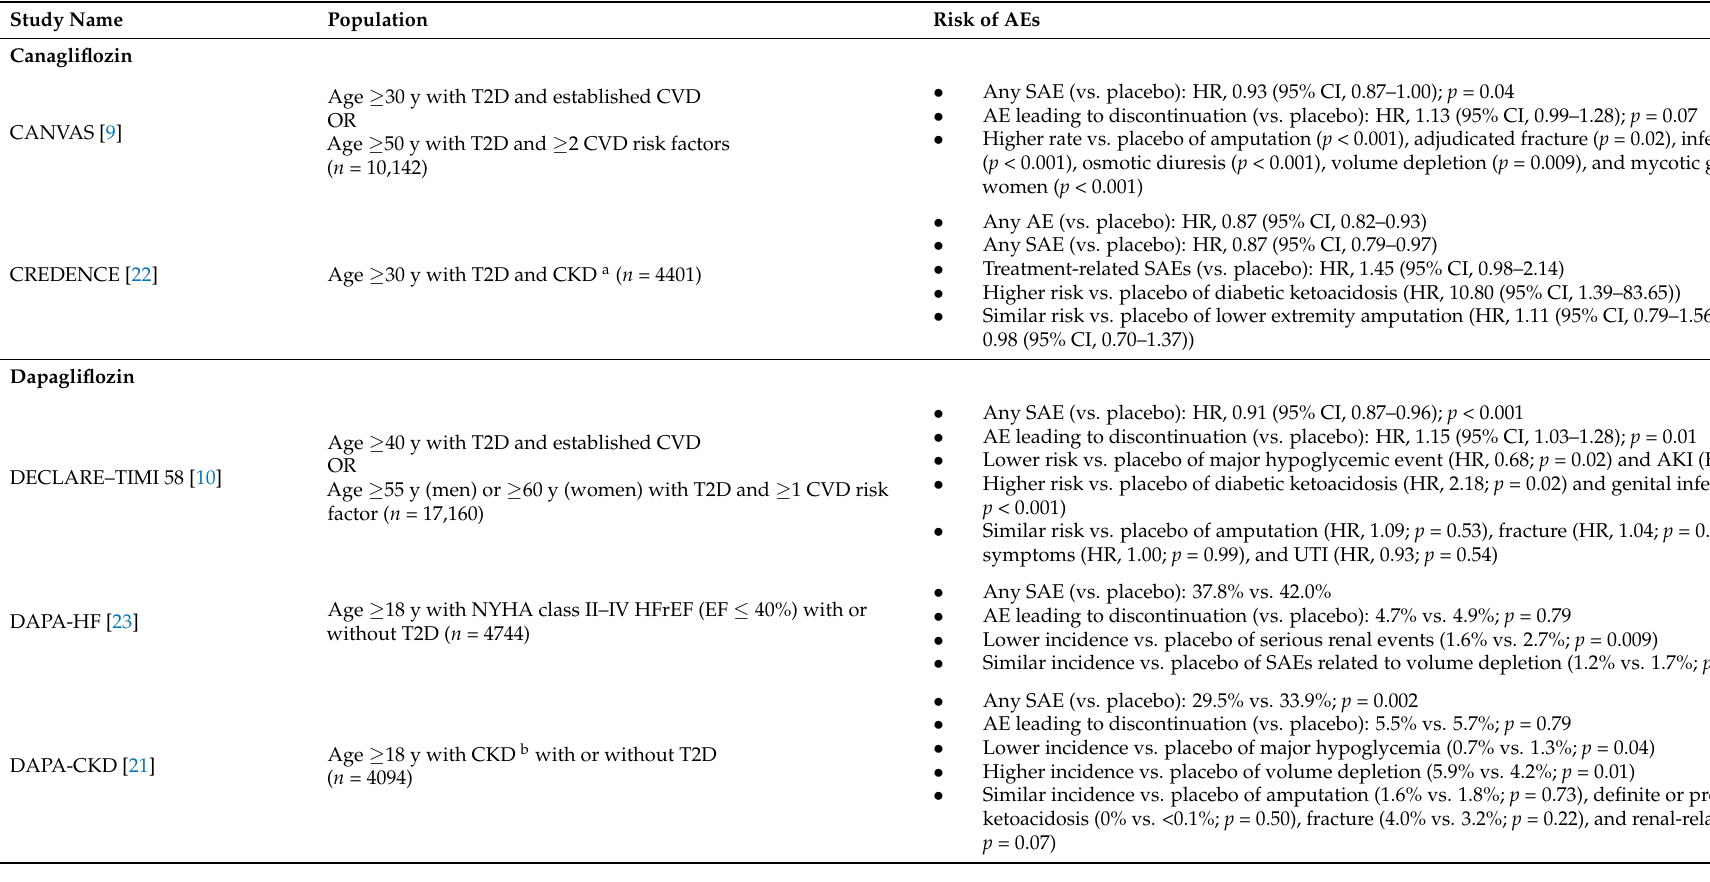
Table 3. Summary of safety results from the SGLT-2i outcome